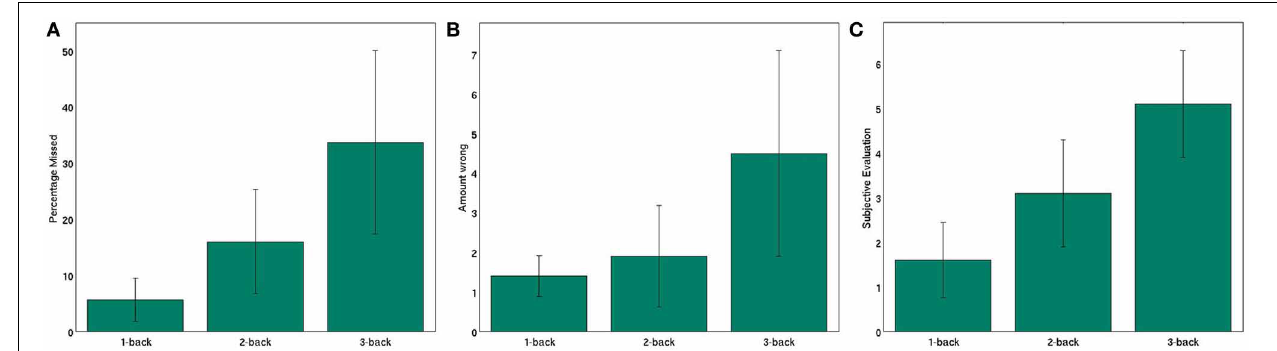
FIGURE 3 | User performance and subjective evaluation in the n -back task (A) average number of missed targets (B) average number of wrong reactions (C) average subjective evaluation of task difficulty. Whiskers